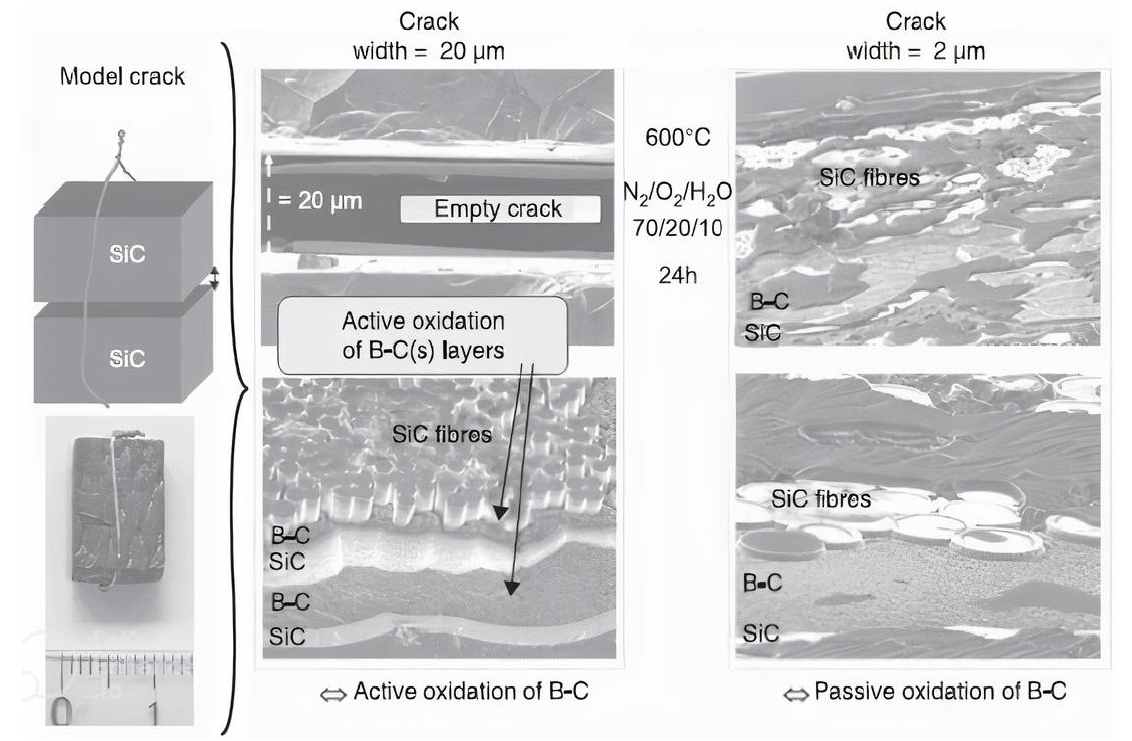
Figure 16. Self-healing in the model of planar crack at different ranges [162].